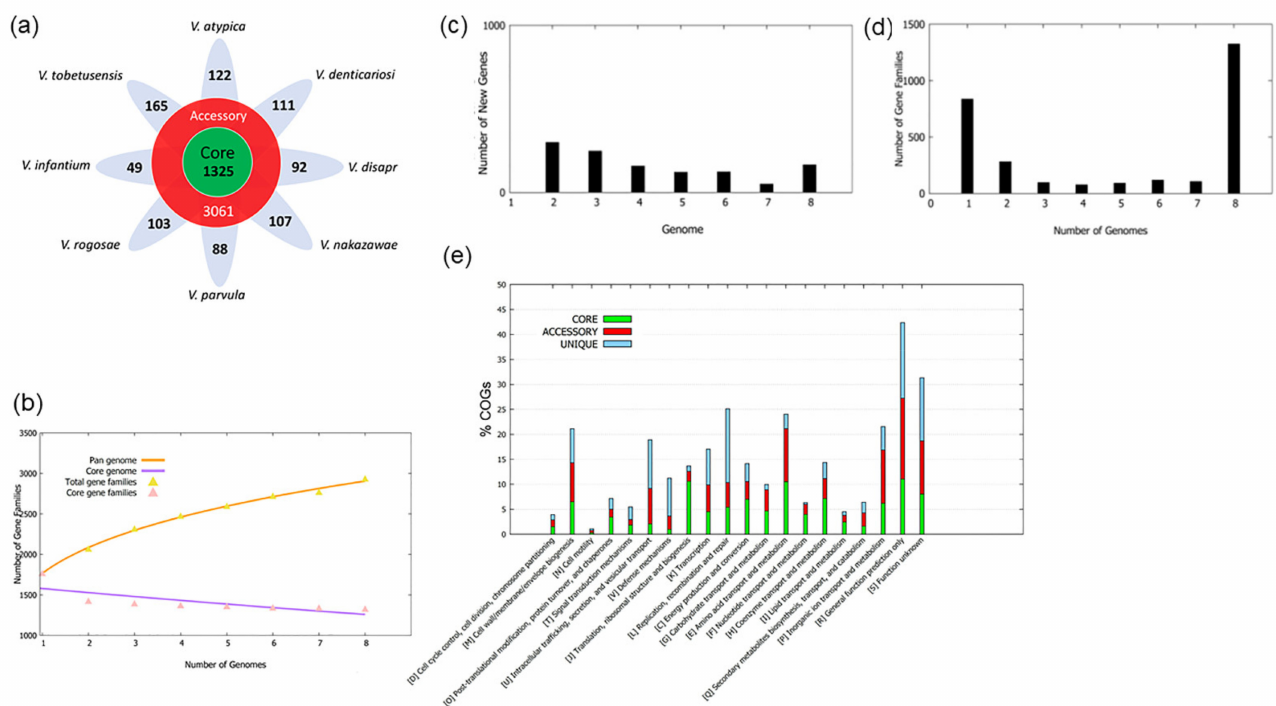
Figure 1. Genetic diversity in oral Veillonella . Each number of genomes represents organism names: 1. V. atypica , 2. V. denticariosi , 3. V. dispar , 4. V. nakazwae , 5. V. parvula , 6. V. rogosae , 7. V. infantium , 8. V. tobetsuensis . ( a ) Core, accessory and unique gene families of the eight type strains of oral Veillonella . The number of core genomes shared by all strains is in the center (1325) using green color. The total number of accessory genomes shared by two-seven strains is shown in red color circle (3061). The number of non-overlapping portions of each oval represents the size of unique genes shown in light blue. ( b ) A pan and core genome plot of oral Veillonella . The plot shows how the number of gene families increase and decline in the pan and core genome with each consecutive addition of a Veillonella genome. ( c ) New genes distribution after sequential addition of each genome to the analysis. ( d ) The gene family frequency spectrum. ( e ) COG distribution of core, accessory and unique genes. Classes D, M, N, O, T, U and V belonging to the category of Cellular processing and signaling. Classes J, K, and L belonging to the category of Information storage and processing. Classes C, G, E, F, H, I, Q and P belonging to the category of Metabolism. Classes R and S belonging to the category of Poorly